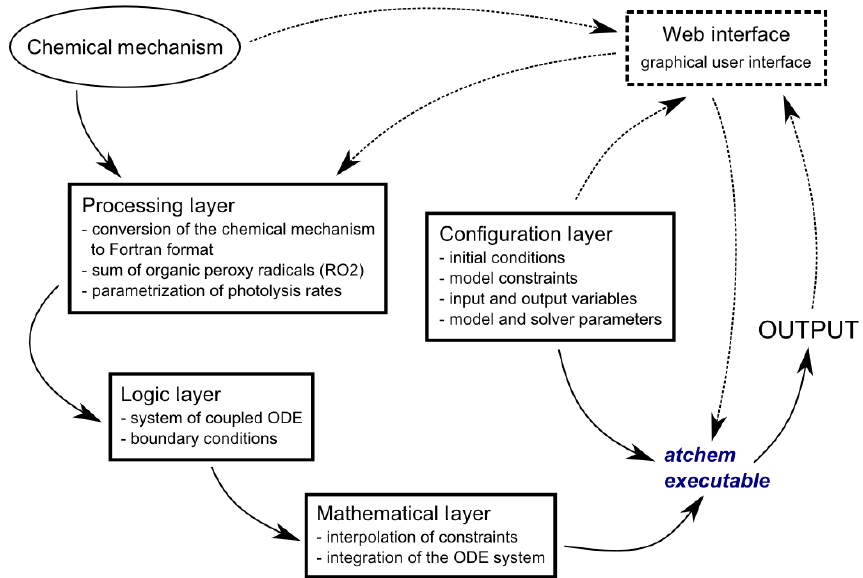
Figure 1. Structure of the AtChem model. The dashed lines indicate the model components that are present in AtChem-online, but not in